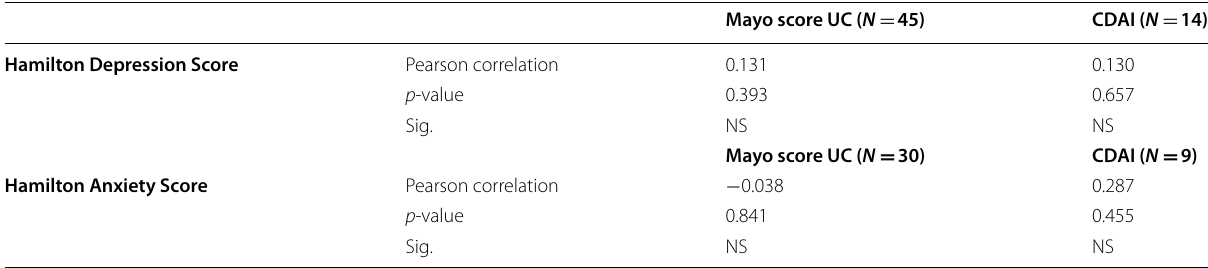
Table 6 Correlation between the total score of HAM-D and HAM-A with Mayo score of UC and CDAI score of Crohn’s disease